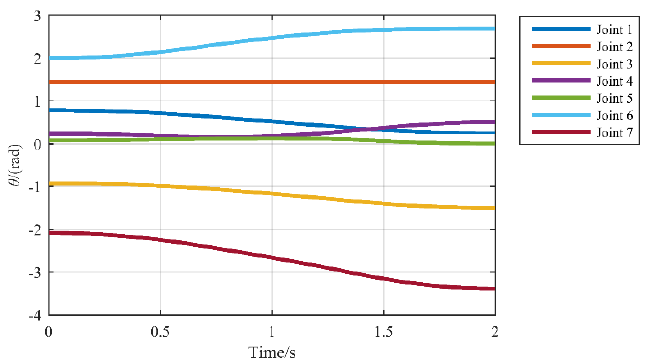
Figure 11. Variation of all joint angles.